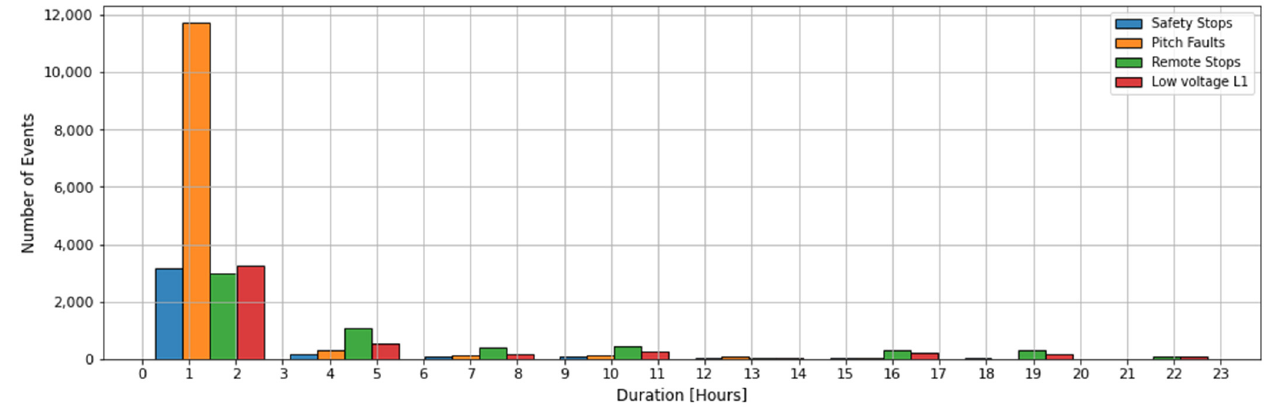
Figure 5. Histogram of alarm durations (detection–reset) for selected faults.